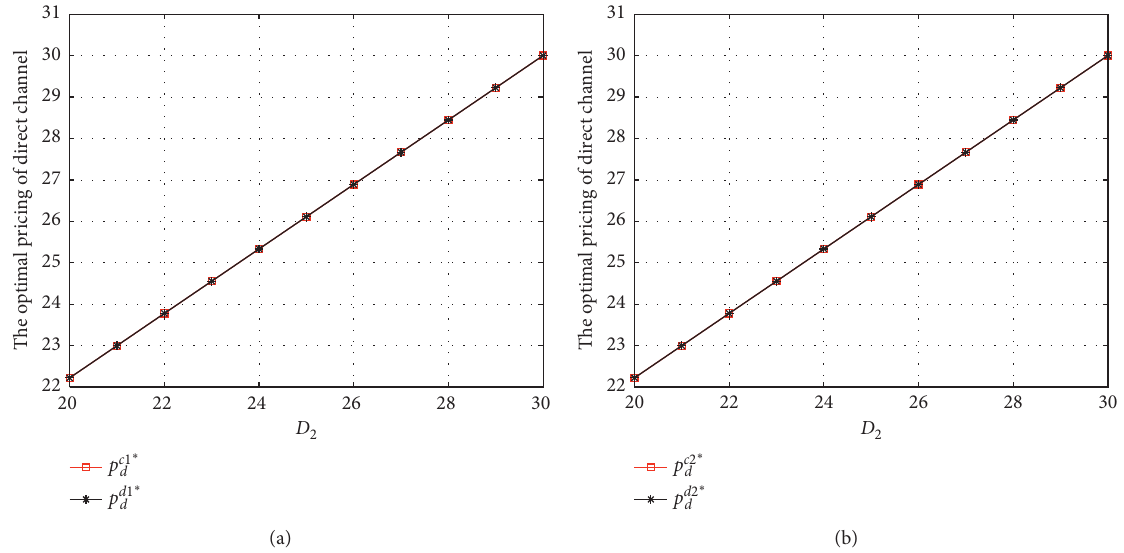
Figure 4: The optimal direct selling price under the centralized and decentralized model.